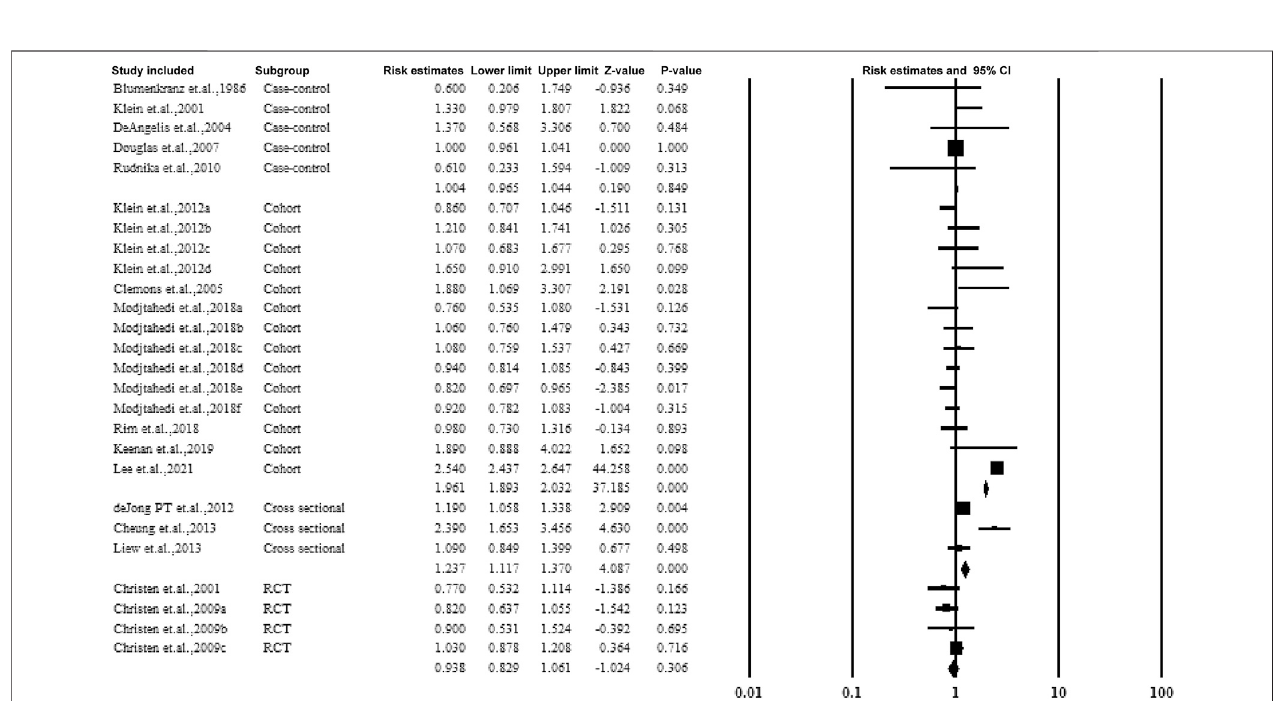
FIGURE9| Christenetal.,2009a – c:dataforvisuallysigni fi cantAMD,advancedAMD,andAMDwithorwithoutvisionloss,respectively.Modjtahedietal.,2018a – f, data for longer use-, new user-, and former-user of aspirin on exudative AMD, longer use-, new user-, and former-user of aspirin on nonexudative AMD, respectively.